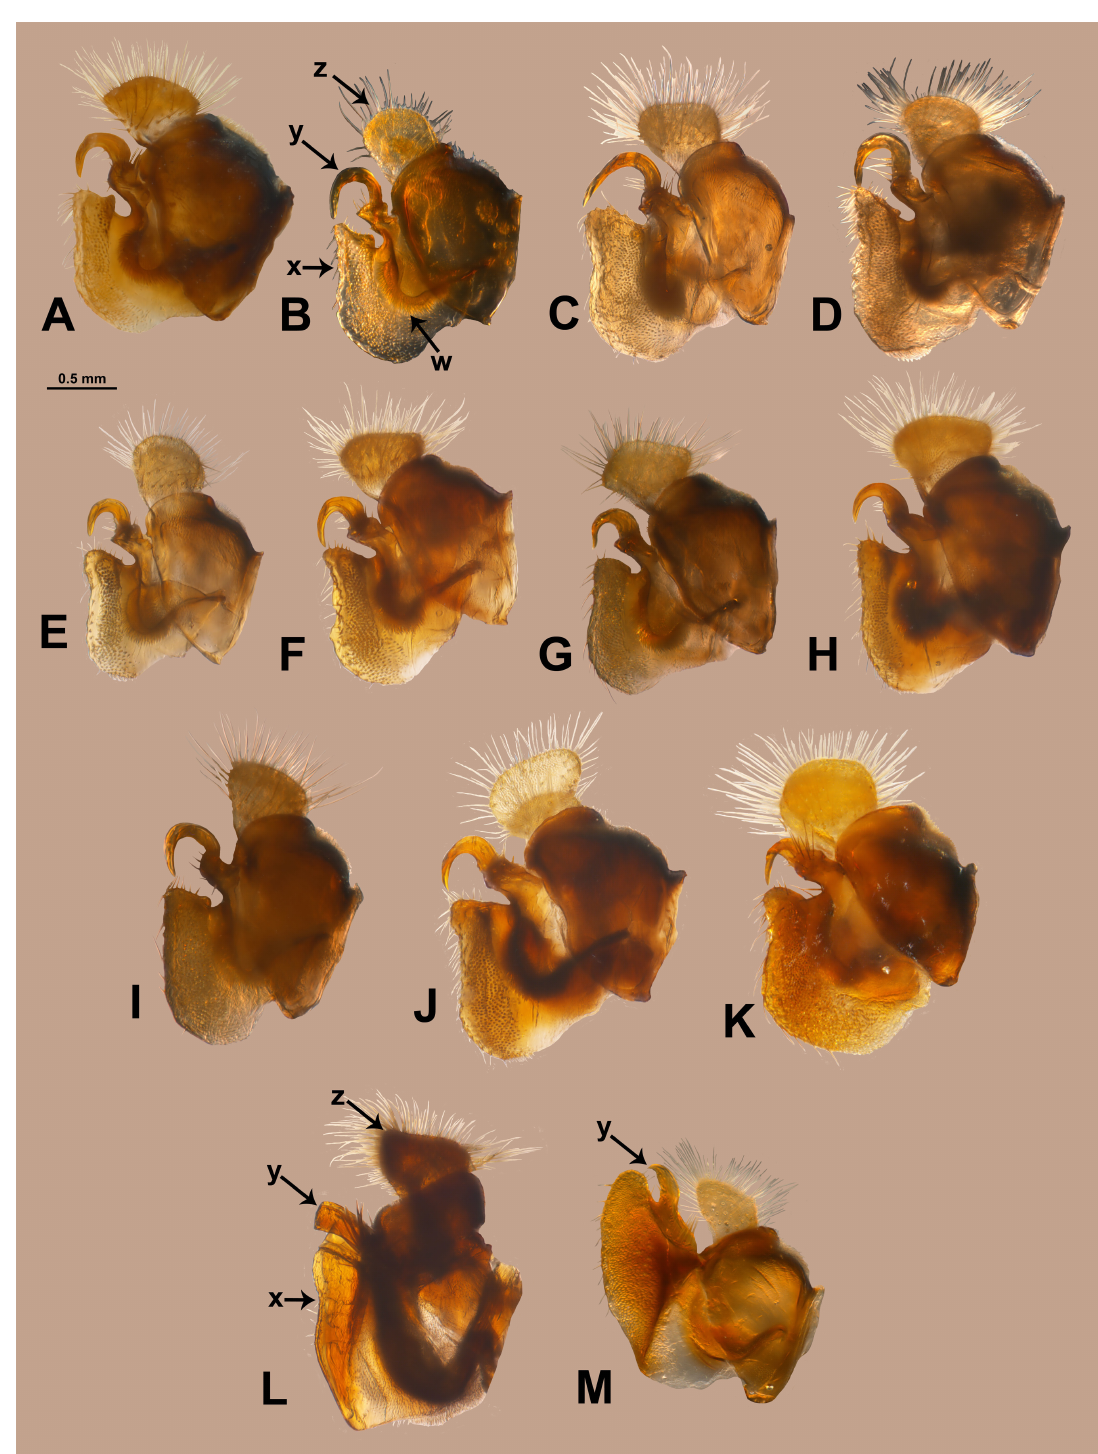
Fig. 10. Megatrigon spp., ♂ terminalia, epandrium, left lateral view. A . Megatrigon argenteus (Walker, 1852) comb. nov. B . M. argentifrons sp. nov. C . M. argentimaculatus sp. nov. D . M. magnicornis sp. nov. E . M. natalensis sp. nov. F . M. sexmaculatus sp. nov. G . M. apiformis sp. nov. H . M. cooksoni sp. nov. I . M. immaculatus sp. nov. J . M. ochreatus (Hull, 1964) comb. nov. K . M. tabanoides sp. nov. L . Megatrigon sp . from sexfasciatus group. M . M. nivalis . Symbols: x = ventral margin of median surstyle; y = posterior surstyle; z = cercus; w = subepandrial